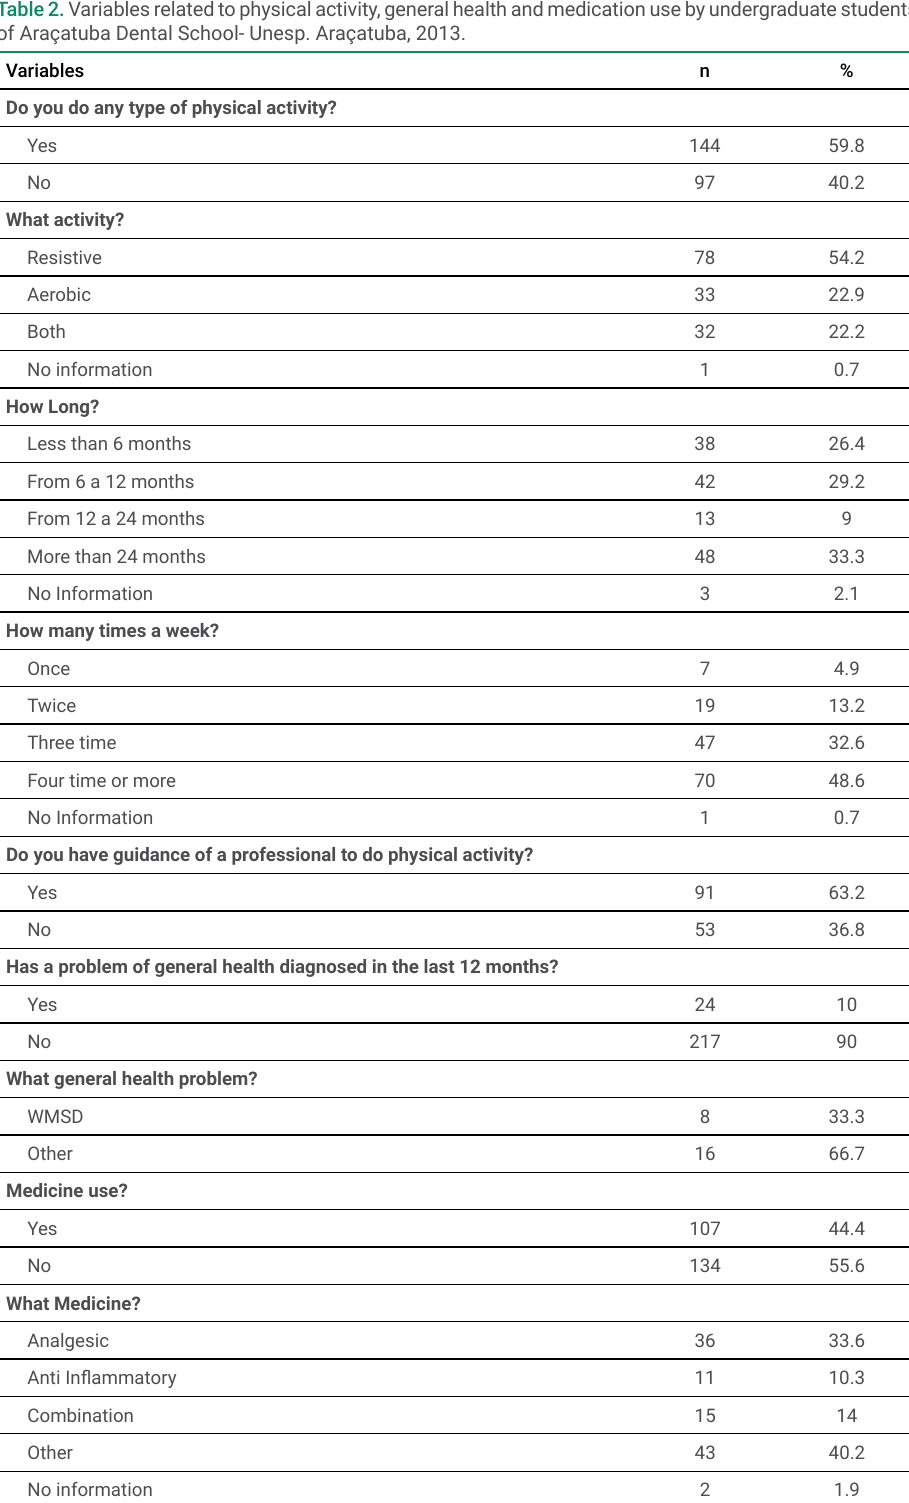
Table 2. Variables related to physical activity, general health and medication use by undergraduate students of Araçatuba Dental School- Unesp. Araçatuba, 2013. Variables n